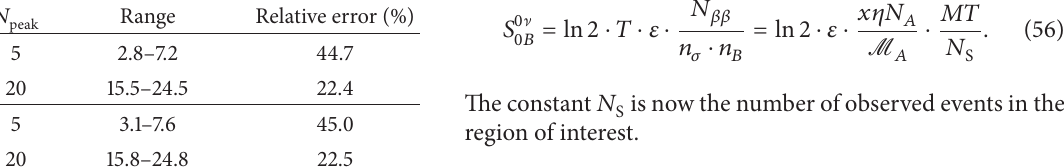
Table 6: 1𝜎 ranges for both Gaussian and Poisson distributions . In the former case, we assumed a for two different values of 𝑁 peak standard deviation equal to √𝑁 . To compute the error columns, peak we halved the total width of the range and divided it by 𝑁 . peak Distribution 𝑁 Range Relative error (%) peak 5 2.8–7.2 44.7 Gauss 20 15.5–24.5 Poisson